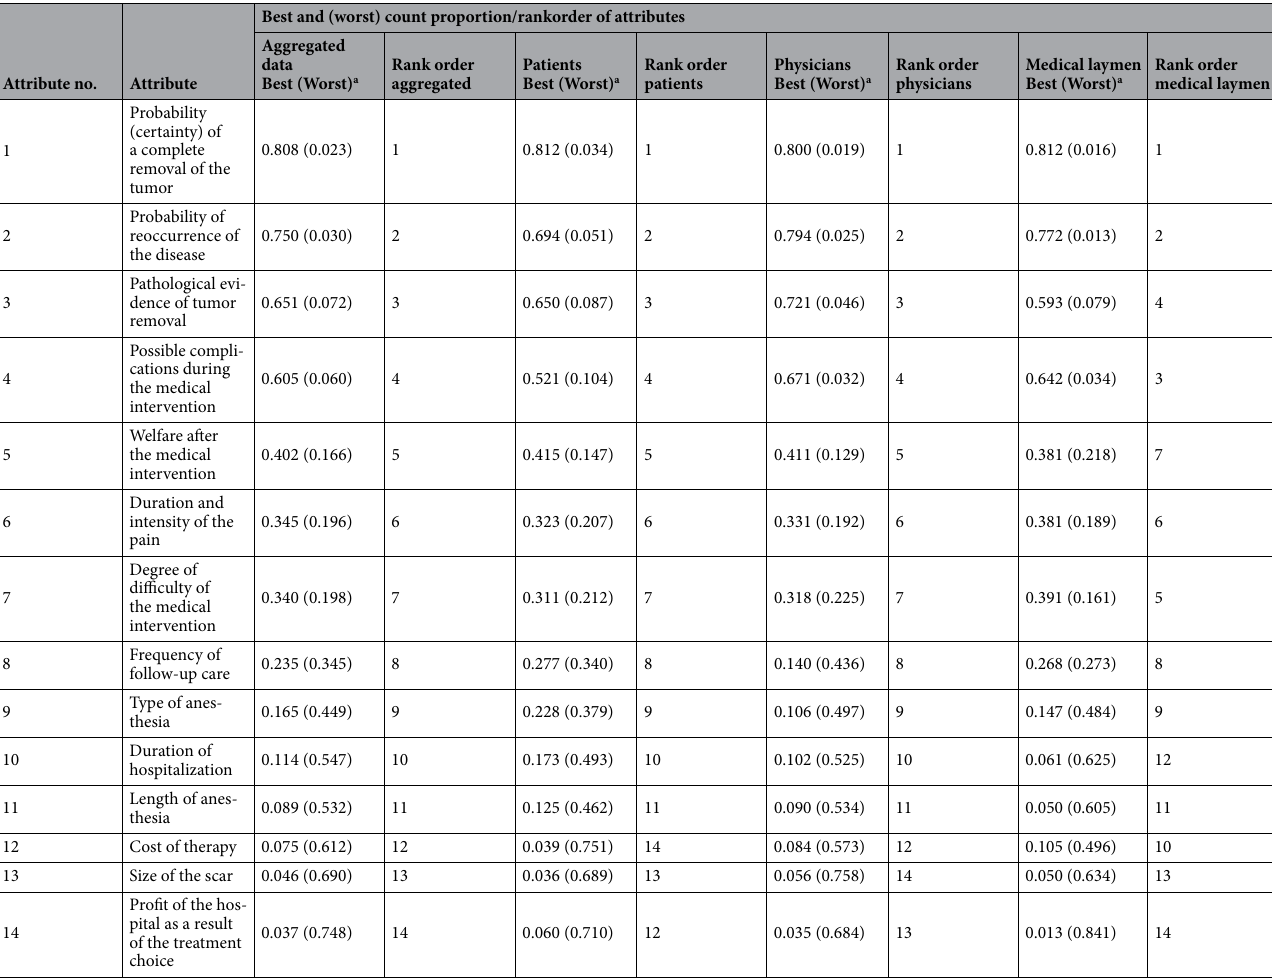
Table 4. Absolute MaxDiff clinical attributes ranking – count analysis. a The first value indicates the Best Count proportion, values given in the parenthesis indicates the Worst Count